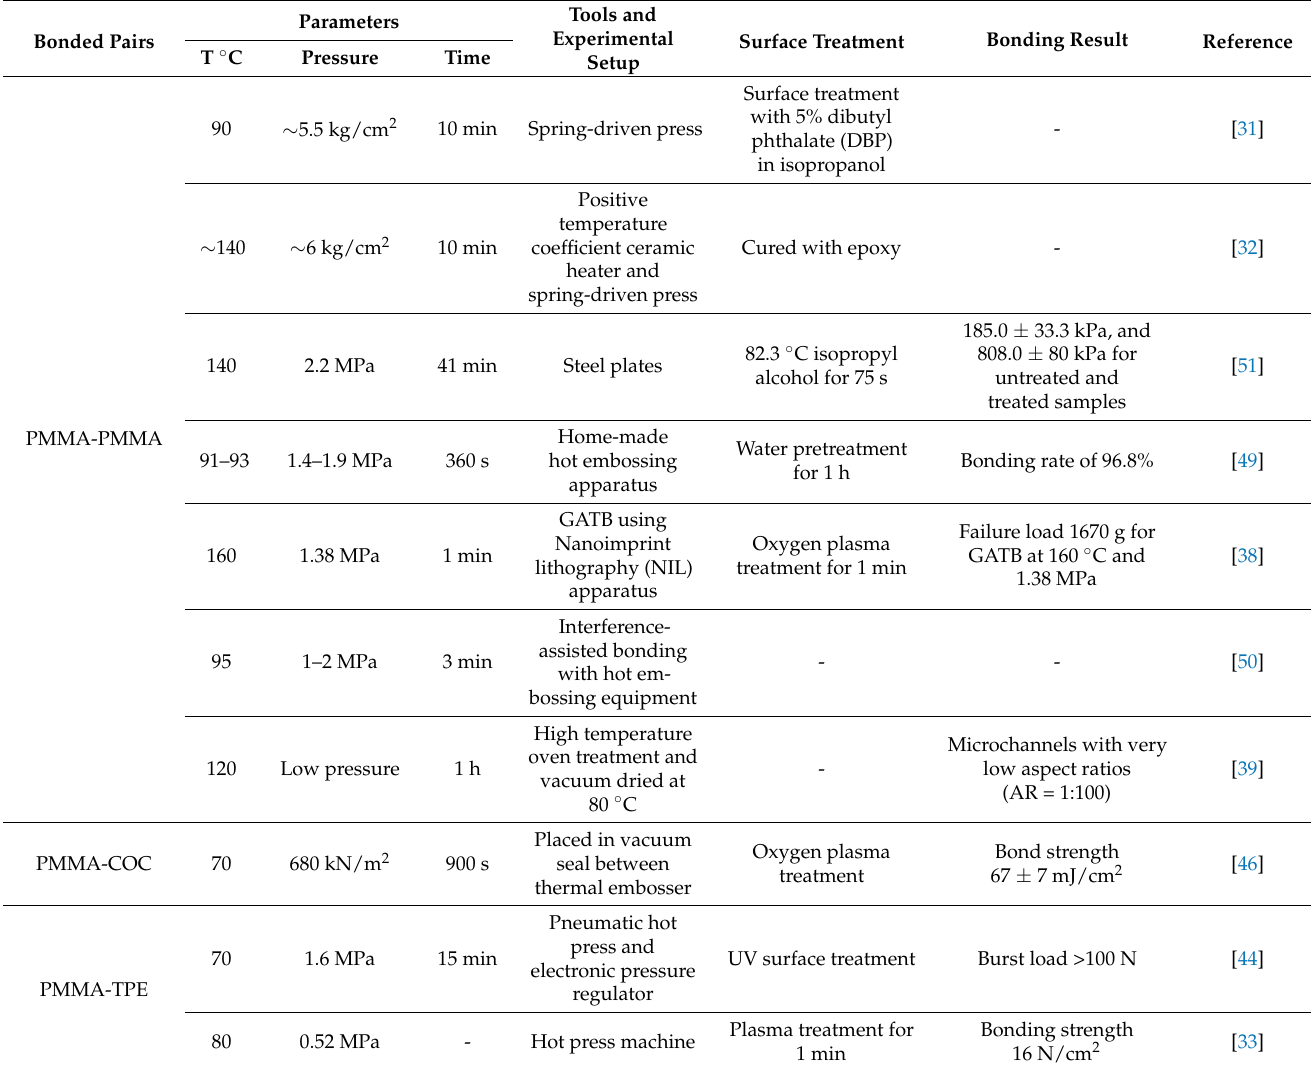
Table 2. Thermally bonded pairs, parameters, tools required, surface treatment and bonding result. Parameters Tools and Experimental Bonded Pairs